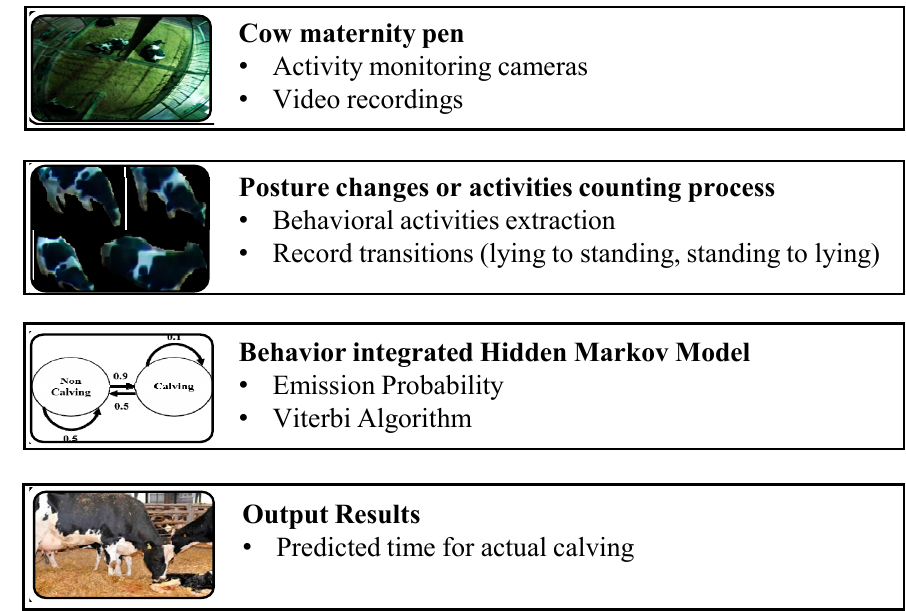
Figure 2. Overview of proposed dairy cow calving time prediction.